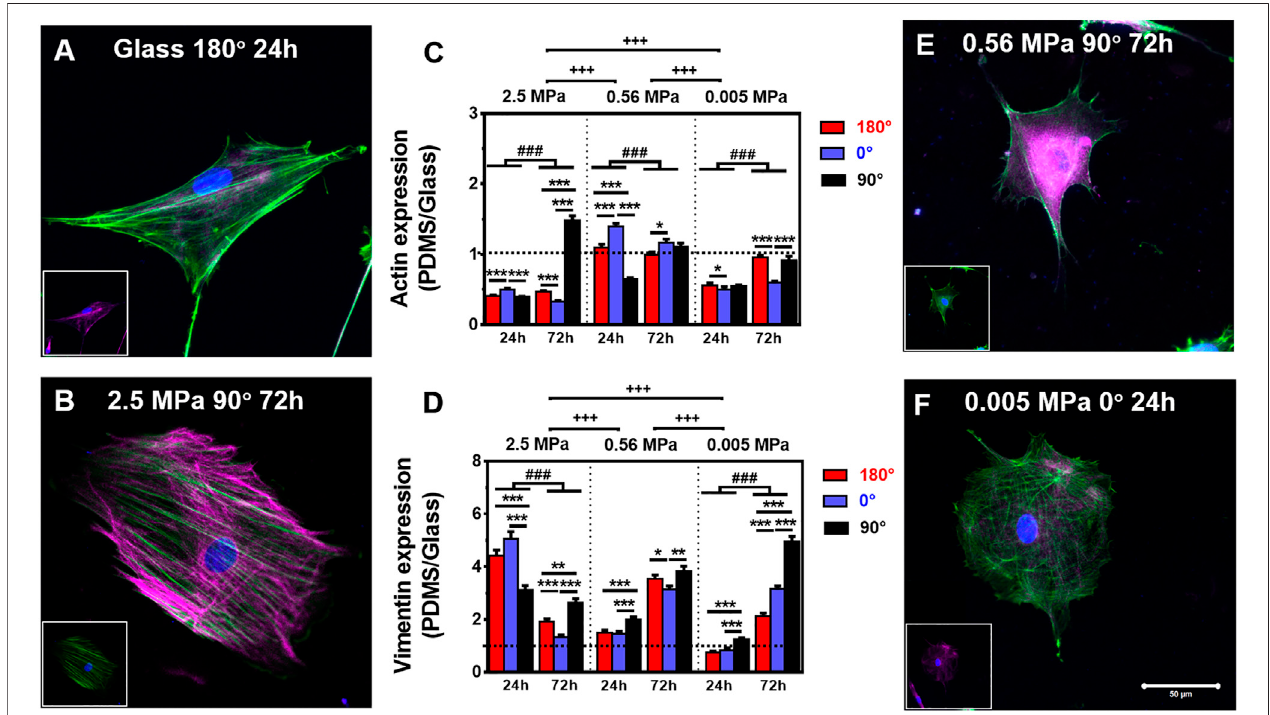
FIGURE 2 | Comparison of actin (green) and vimentin (magenta) expressions. (A,B,E,F) Typical merged cytoskeletal images for cells placed onto glass: (A) 180 ° , 24 h, 2.5 MPa, (B) 90 ° , 72 h, 0.56 MPa, (E) 90 ° , 72 h, or 0.005 MPa, (F) 0 ° , 24 h, poly-dimethylsiloxane (PDMS). The insert in each panel denotes the isolated cytoskeletal image for clarity. Bar = 50 µm. (C,D) Relative fl uorescent intensity onto PDMS normalized to that onto glass was plotted for actin (E) or vimentin (F) in three orientations and presented as mean ± SE for ~45 cells from three repeated experiments at 24 or 72 h. *, **, or ***, t -test, p < 0.05, 0.01, or 0.001; ### , two-way ANOVA test for different groups with different time with cell orientation, p < 0.001; +++ , three-way ANOVA test for differences among stiffness, orientation, and duration, p <